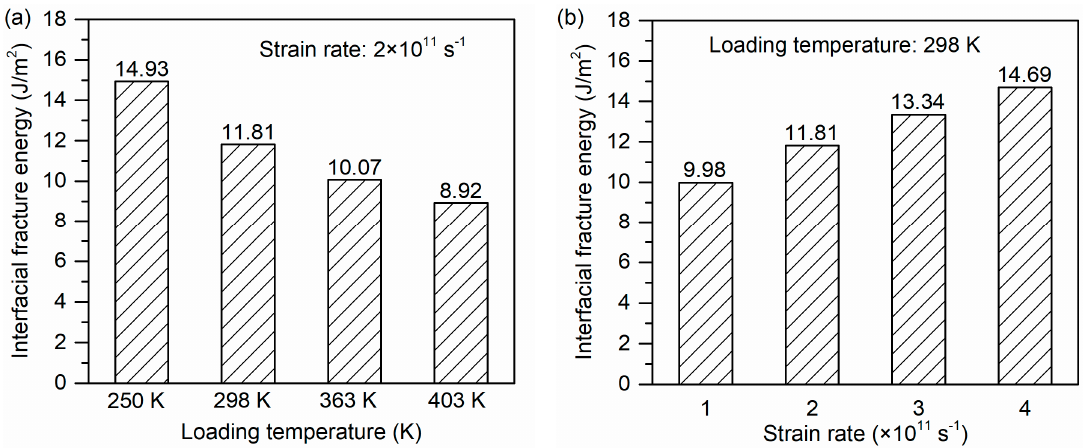
Figure 11. The interfacial fracture energy of glass fiber/PP composites under different loading conditions: ( a ) loading temperatures and ( b ) strain rates.